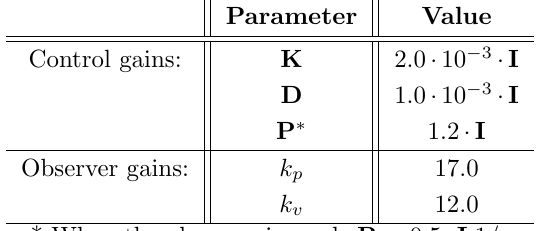
Table 1: SM controller and observer gains.